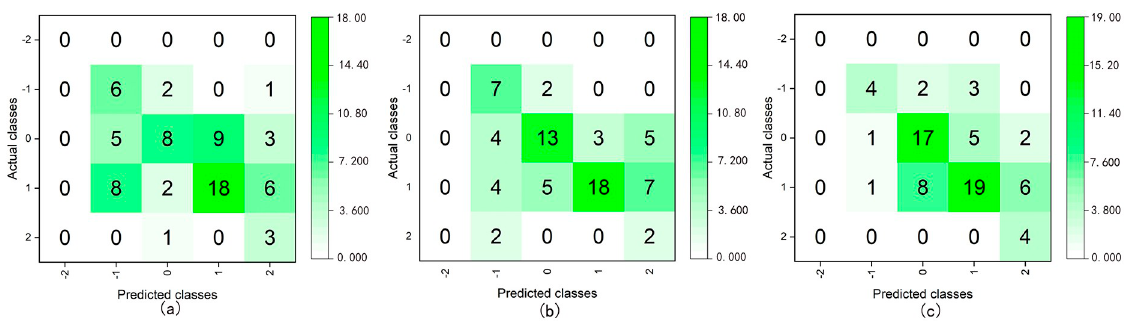
Fig 11. Confusion matrices of the quinary class classification for external validation using the DT C5.0 (boosting) (a), RF (bagging) (b), and ANN (boosting) (c).